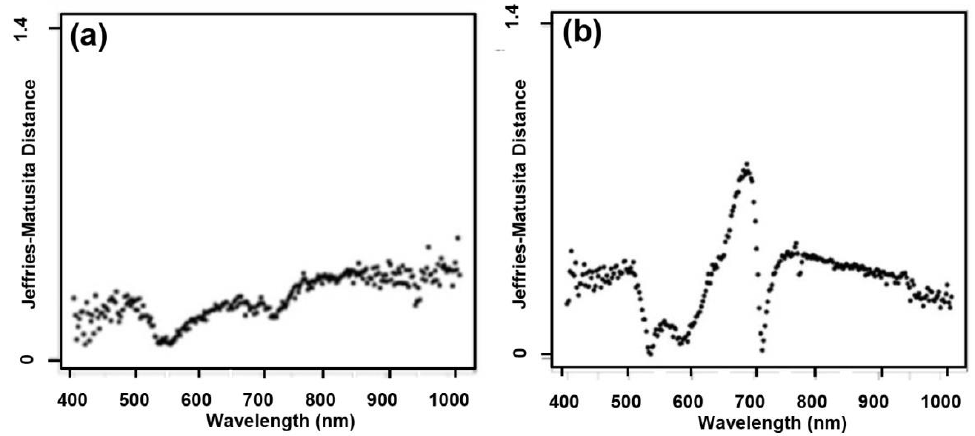
Figure 7. The Jeffries-Matusita distance measure for each of the 273 spectral bands (400 nm to 1000 nm): ( a ) JM measure between healthy class and freshly damage class; ( b ) JM measure between healthy class and old damage class.